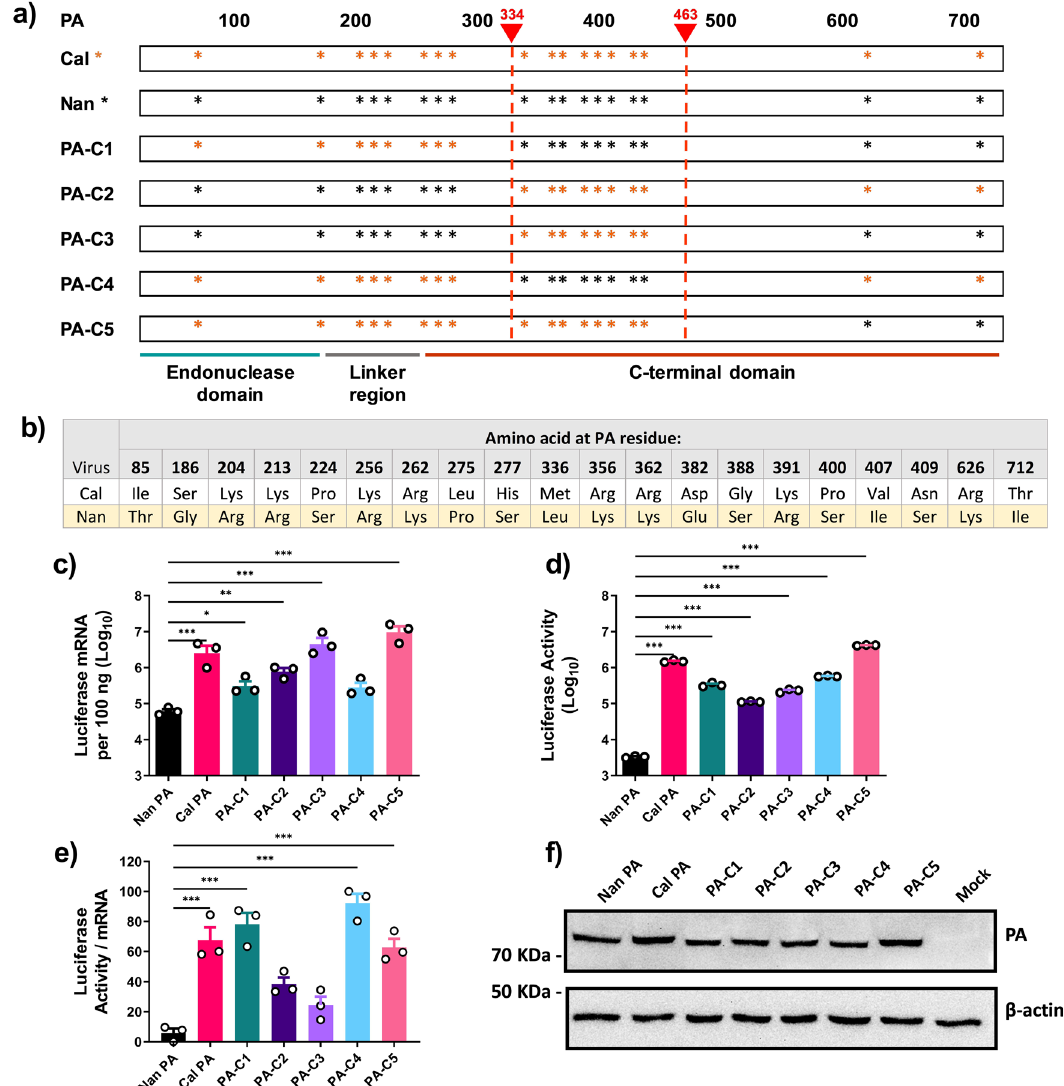
Fig. 2 The N-terminal region of Cal PA enhances the translation ef fi ciency of viral mRNA. a Diagram showing the chimeric PA constructs. The asterisks indicate differences in amino acids. b Amino acid differences between Cal and Nan PA. c – f 293 T cells were transfected with expression plasmids for Nan NP, PB1, PB2 and the indicated PA subunits along with pPolI-NP-luc. c Luciferase mRNA was quanti fi ed by qRT-PCR. d Luciferase activity determined by the Dual-Luciferase Reporter Assay system. e Ratio of luciferase activity per mRNA, transformed to a normal distribution. f Representative image of immunoblot analysis of PA and β -actin in cell lysates using speci fi c antibodies. All error bars show means plus/minus the standard deviations ( n = 3 biological replicates). One-way ANOVA followed by Tukey ’ s multiple comparison test (* P < 0.05, ** P < 0.01, *** P <